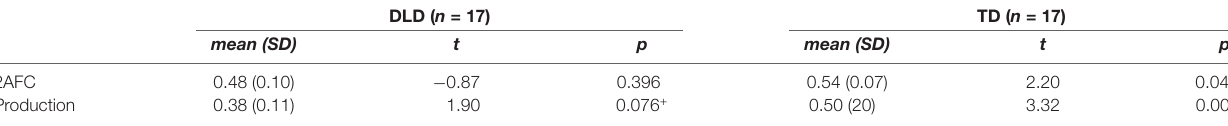
TABLE 4 | Descriptives and comparative statistics of groups performance relative to chance level in the offline acoustic verbal tasks.